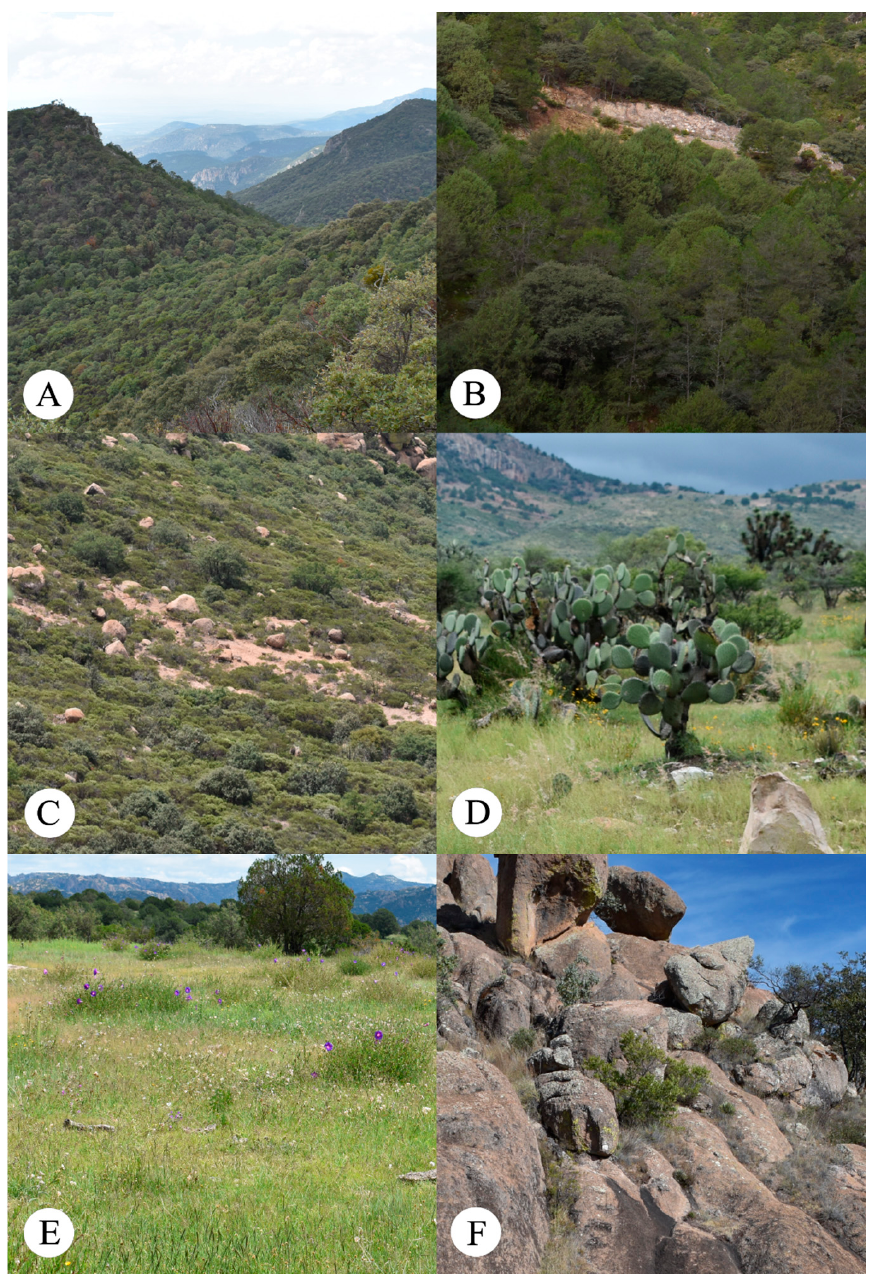
Figure 3. Vascular plant communities of the Sierra de los Cardos, Susticacán, Zacatecas, Mexico. ( A ) = oak forests; ( B ) = pine forests; ( C ) = chaparral; ( D ) = nopaleras; ( E ) = grasslands; ( F ) = rock outcrop vegetation.